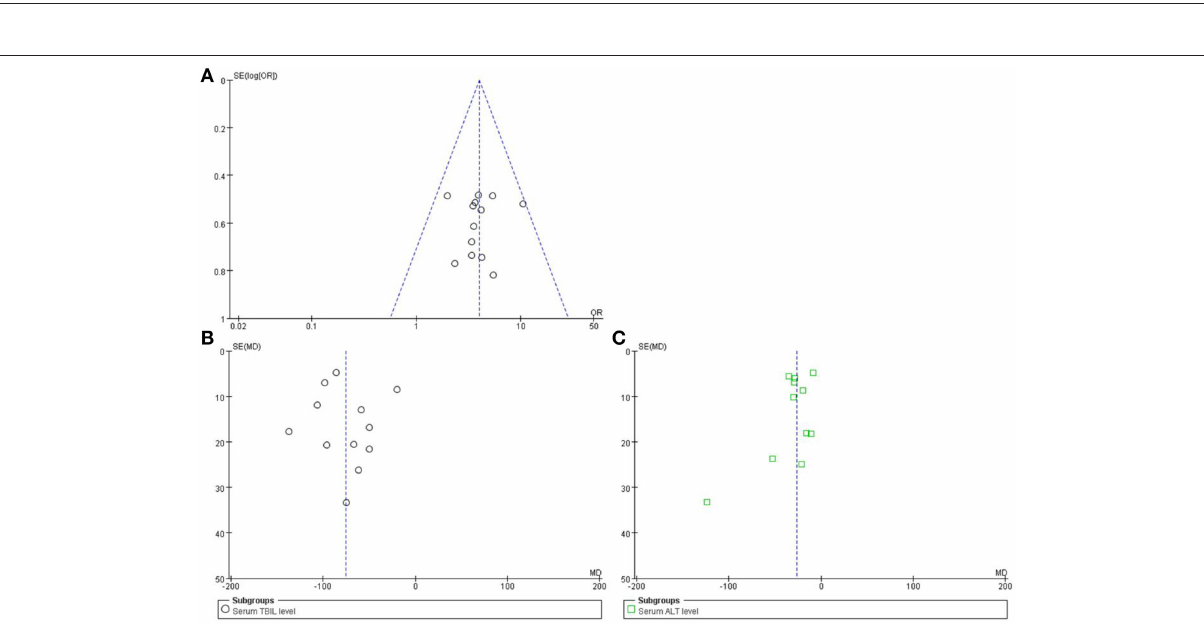
Frontiers in Pharmacology |